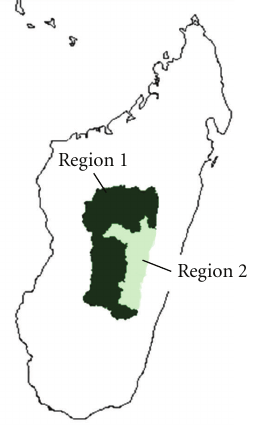
Figure 7: Regions in Madagascar. Region 1 is characterized by high malaria incidence values peaking in March. Region 2 is characterized by low malaria incidence values due to high altitude.